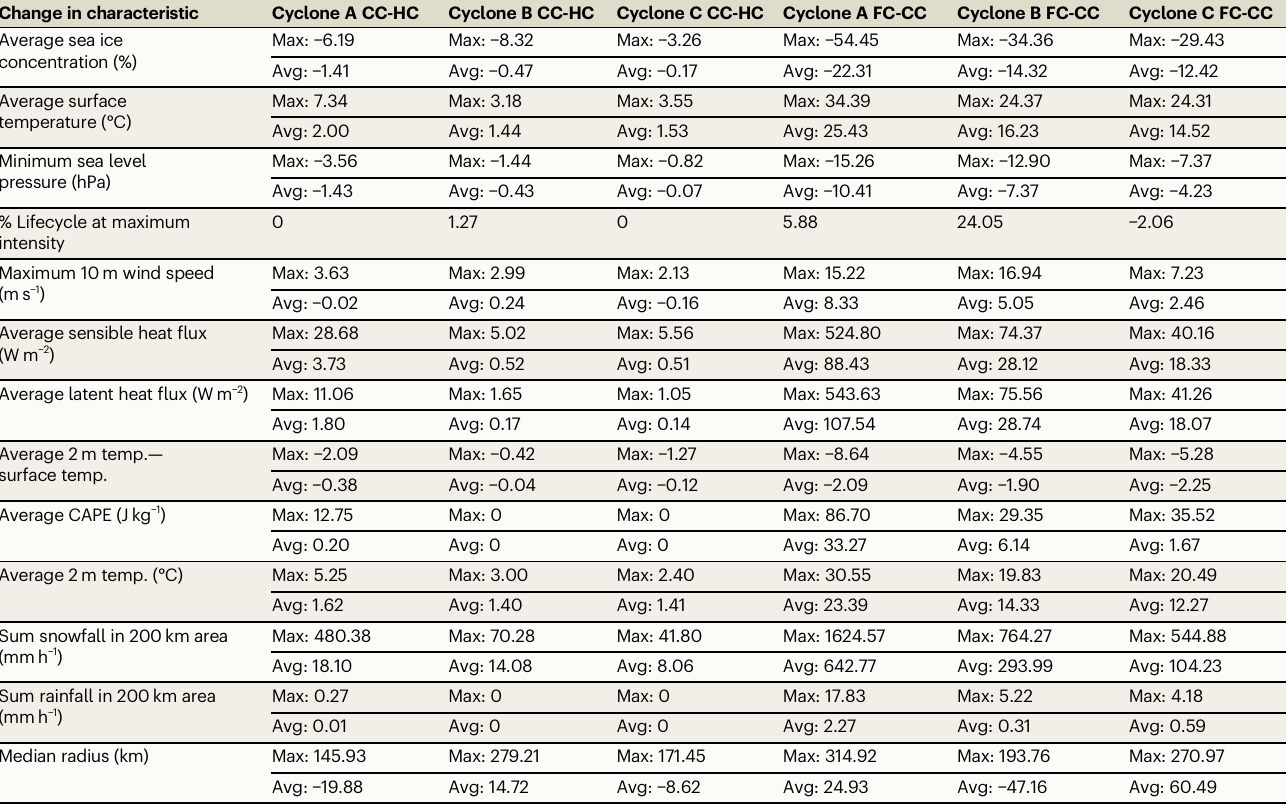
Table 1 | Numerical summary of changes in simulated environmental and cyclone characteristics (Cases A – C) from historical and future climate perturbation Change in